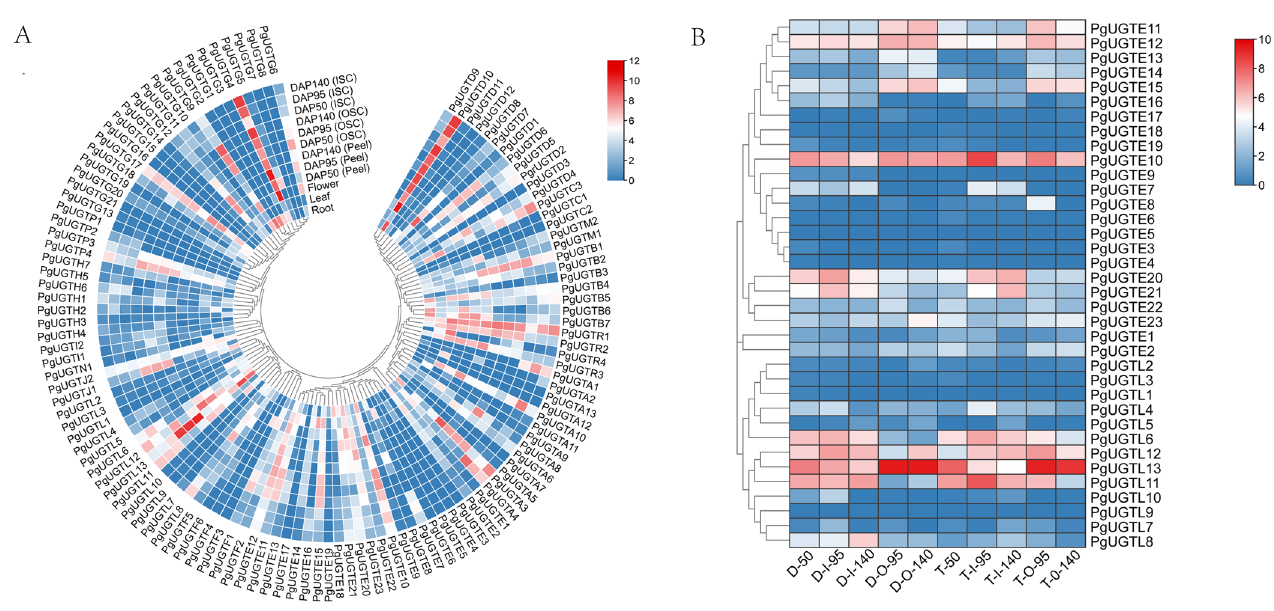
Figure 4. Expression profiles of PgUGT s. ( A ) Expression profiles of PgUGT s in different tissues. Transcript data of PgUGT s in root, flower, leaf, peel, and inner and outer seed coat at 50, 95, and 140 days after pollination (DAP) were normalized with log 2 transformed FPKM values. ISC, inner seed coat; and OSC, outer seed coat. ( B ) Expression profiles of the PgUGT s of groups L and E in seed coats of soft-seeded ‘Tunisia’ and hard-seeded ‘Dabenzi’. The transcript data of PgUGT s in the inner and outer seed coats of ‘Dabenzi’ and ‘Tunisia’ at 50, 95, and 140 DAP were normalized with log 2 transformed FPKM values. D, ‘Dabenzi’; T, ‘Tunisia’; DAP, days after pollination; I, inner seed coat; and O, outer seed